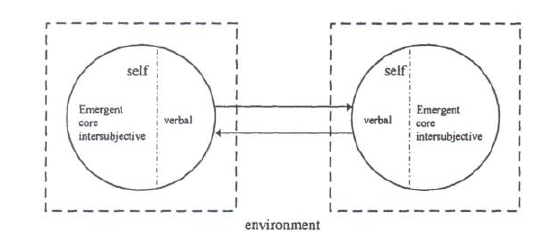
Figure 22: Emergent Stage (Evans 1998 p. 290)